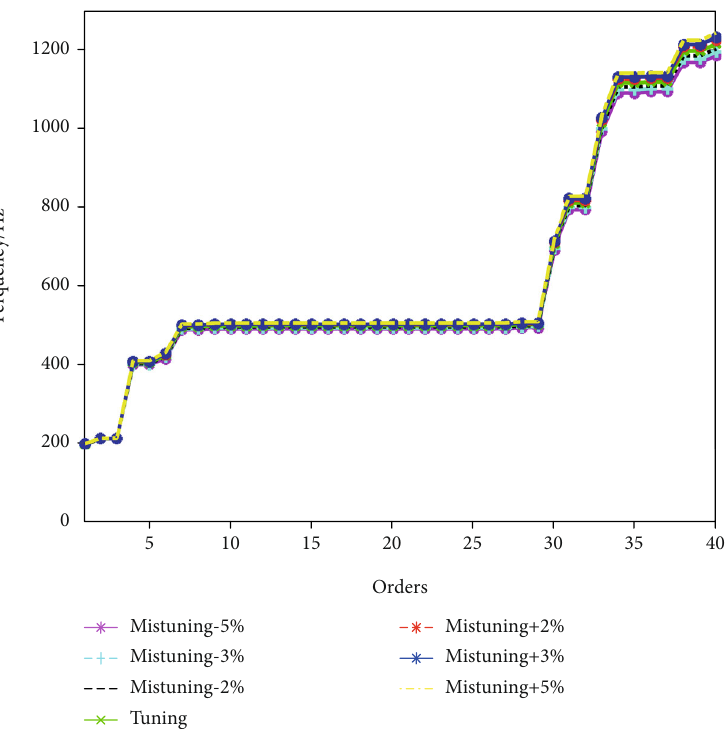
Figure 6: Natural frequencies of mistuned blisk with sti ff ness mistuning.